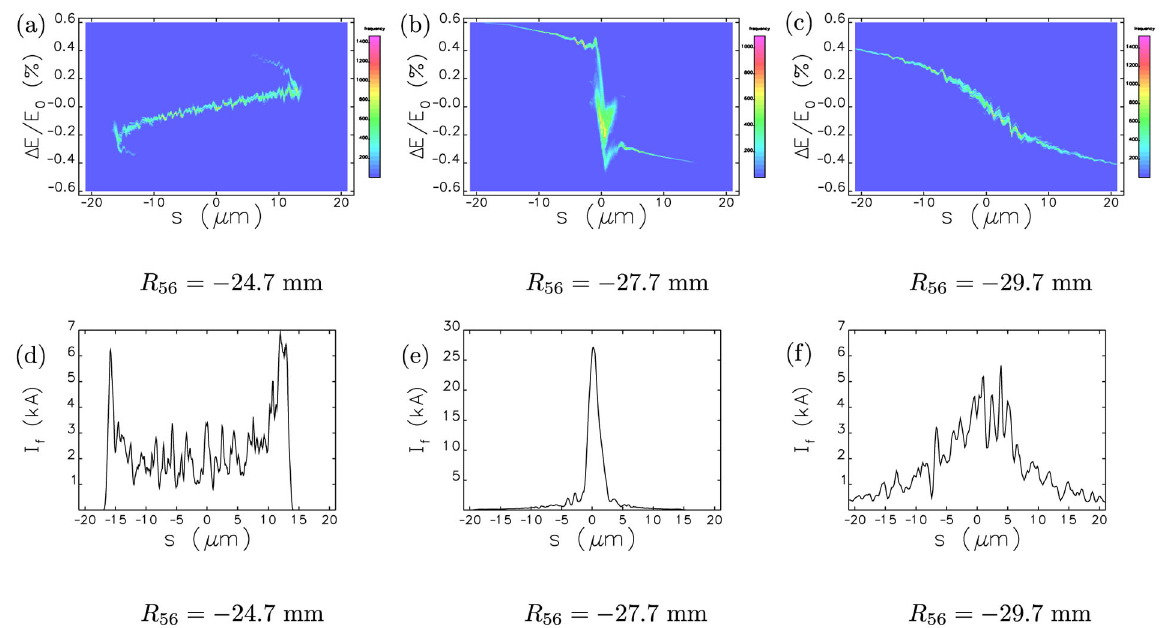
FIG. 9. (Color) ELEGANT simulations of the beam longitudinal phase space distributions (upper plots) and the current profiles (lower plots) in L3 linac at 10 GeV for three BC2 R 56 settings. The bunch head is to the left. (a) R 56 ¼ (cid:2) 24 : 7 mm . (b) R 56 ¼ (cid:2) 27 : 7 mm .